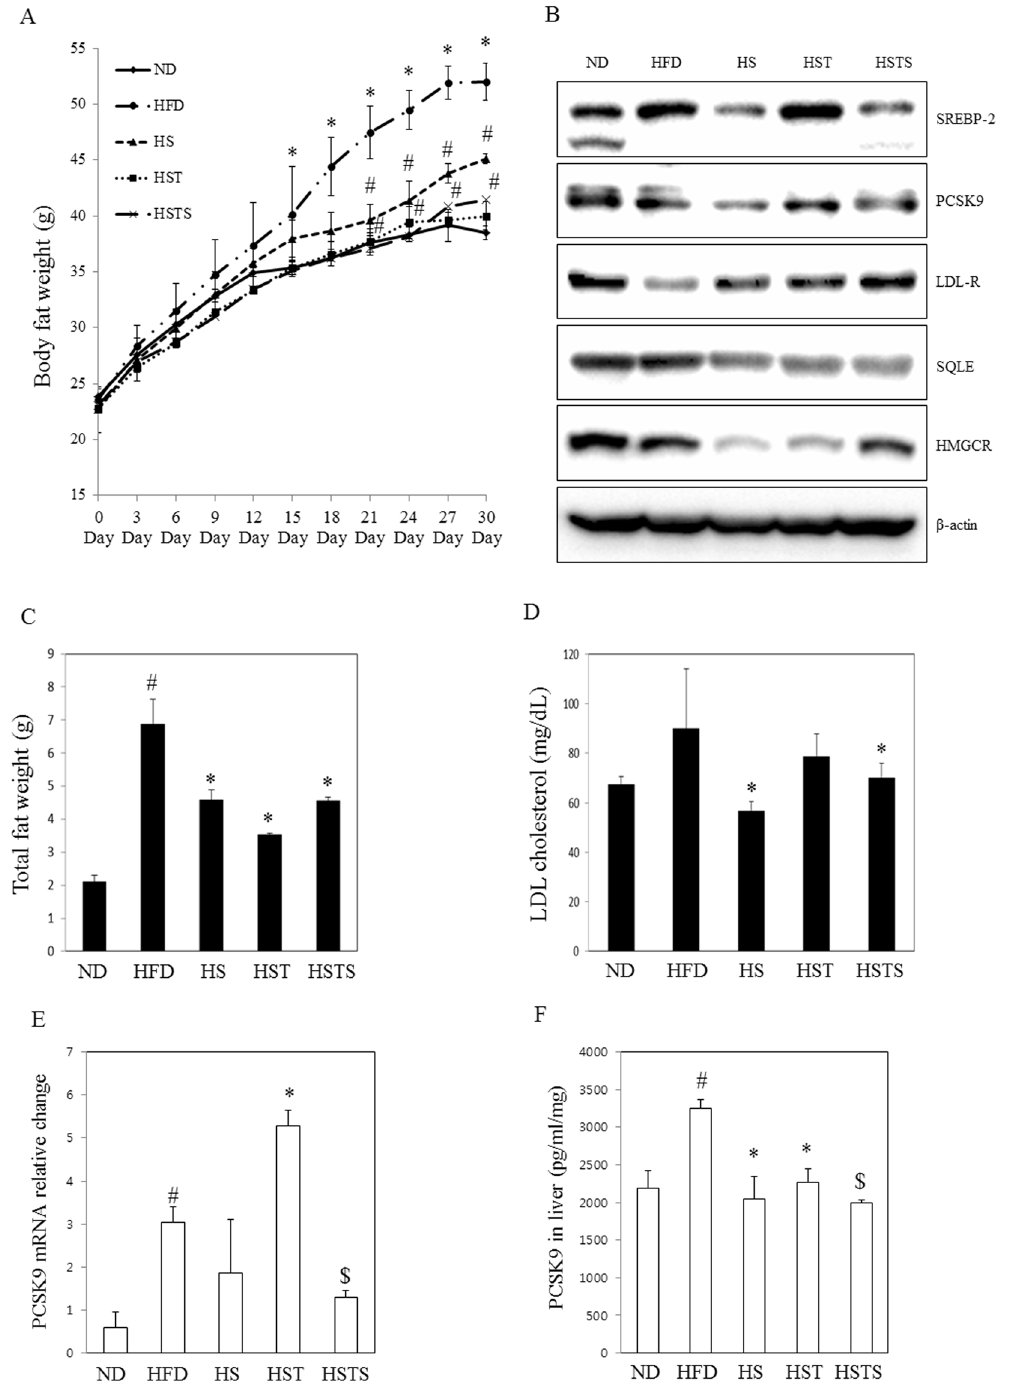
Figure 7. Effects of long-term treatment with sauchinone on the risk of occurrence of hypercholesterolemia in mice. ( A ) Effects of sauchinone on body weight gain. ( B ) The protein expression of SREBP2, PCSK9, LDL- R, SQLE, HMGCR and β -actin was assayed by Western blotting in liver. ( C ) Total fat weight, and ( D ) LDL- cholesterol in plasma in the ND, HFD, HS, HST, and HSTS group. ( E ) PCSK9 mRNA expression was assayed by qRT-PCR in the ND, HFD, HS, HST, and HSTS groups. ( F ) The protein expression of PCSK9 in the liver was assayed by ELISA. Statistical significance of the differences between each treatment group and the ND ( # p < 0.05), HFD ( * p < 0.05) or HST ( $ p < 0.05) group was